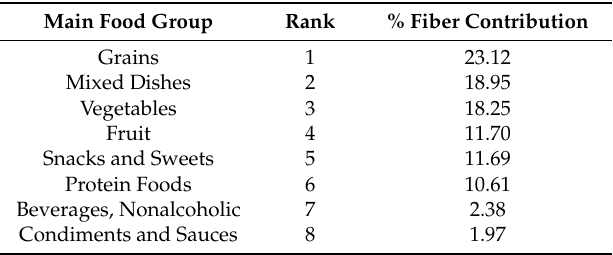
Table 3. Food sources of dietary fiber contribution in the total U.S. diet, adults ≥ 51 years old ( n = 4522; gender combined; daily intake data; NHANES 2011–2014; main food groups contributing <1.0% not reported; data are Day 1 intakes).